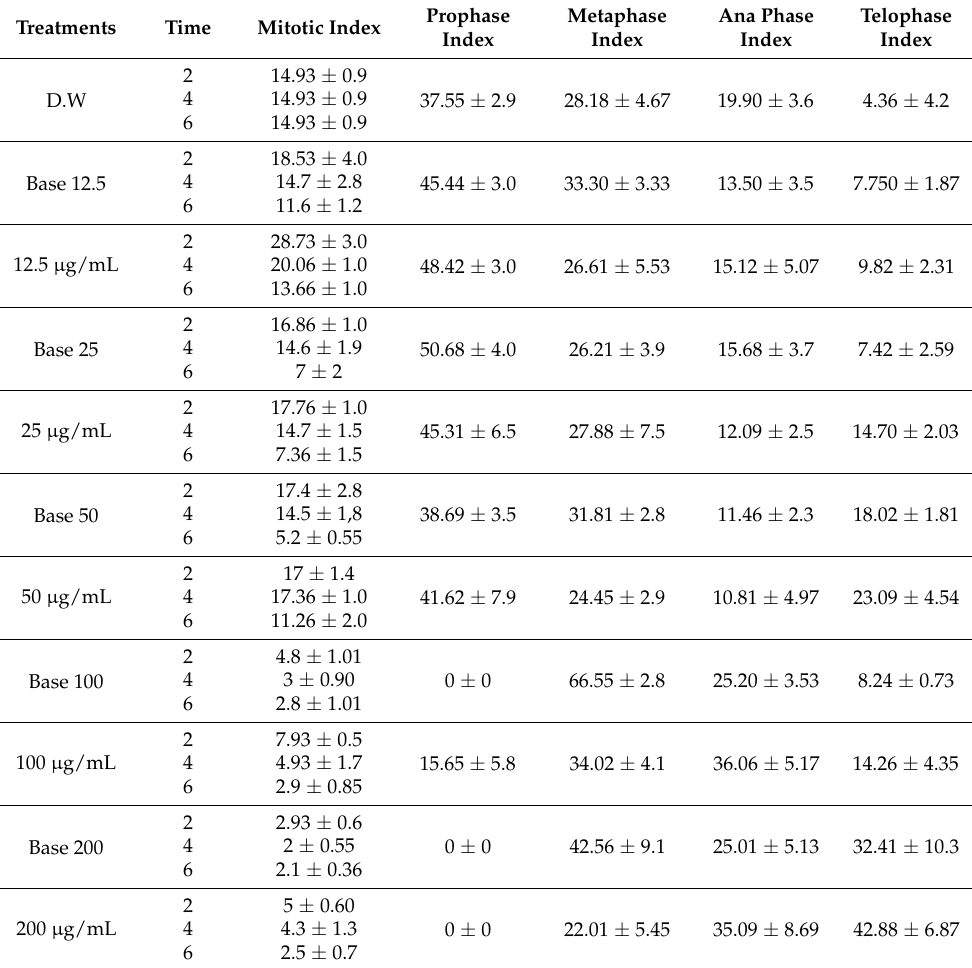
Table 5. Exposure to ZnO-NPs at different concentrations and for different durations of time affected the mitotic index and phase